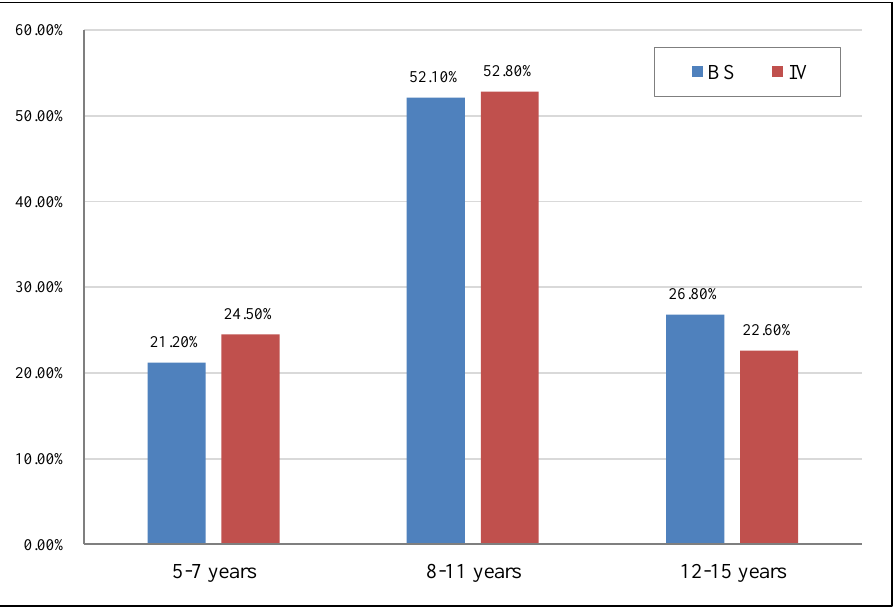
Figure 1. Age groups of respondents